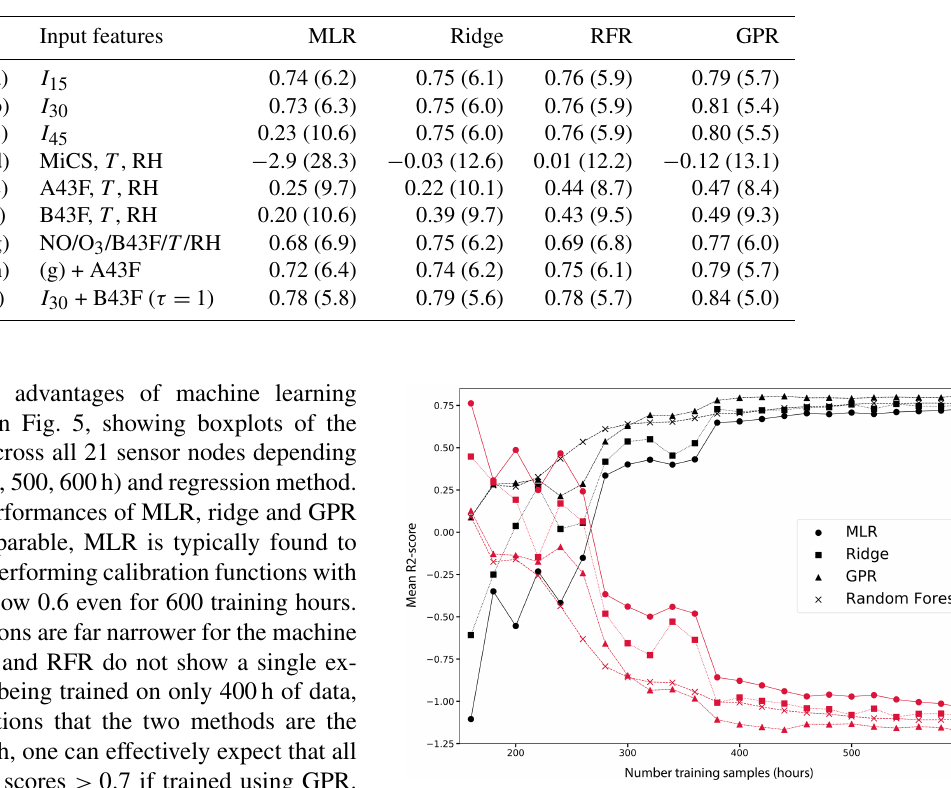
Figure 4. Error metrics as a function of the number of training sam- ples for I 30 , as labelled. The figure highlights the convergence of both metrics for the different regression methods as the sample size increases. Note that MLR would not converge for I 45 , owing to the curse of dimensionality. This tendency can also be seen here for small sample sizes, where MLR rapidly loses performance. Results are averaged over the 21 low-cost sensor nodes with 600 hourly training samples each, and the evaluation is carried out for 220 test samples